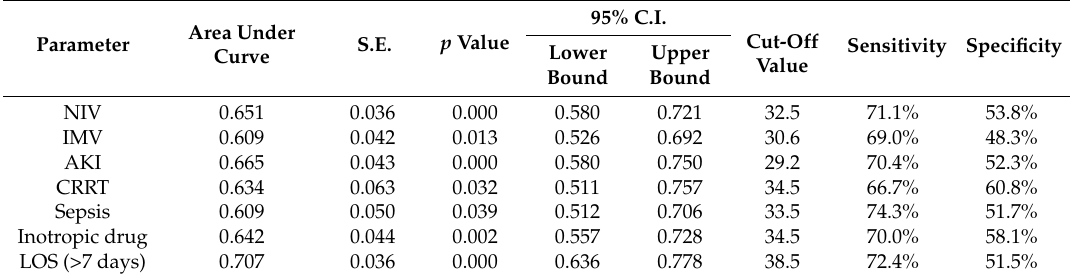
Table 4. Analysis of uric acid and prognostic factors by ROC analysis in PICU patients.